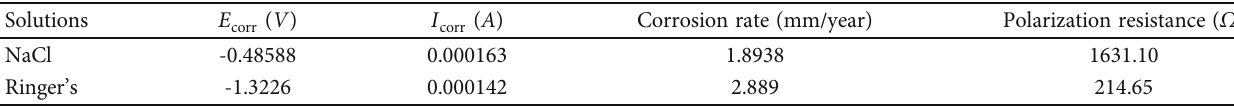
Table 2: Polarization data for NaCl and Ringer ’ s